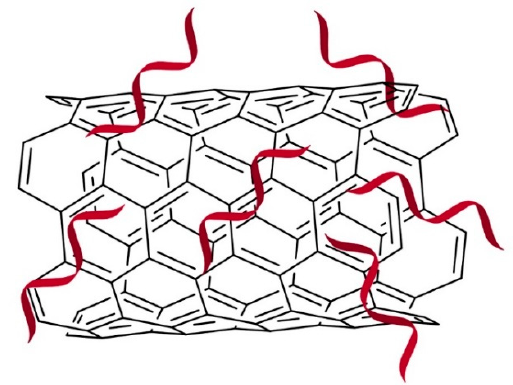
Figure 4. Surface modi fi ed CNT (cations) a tt racts and ‘captures’ negatively charged RNA strands. Color image available online.